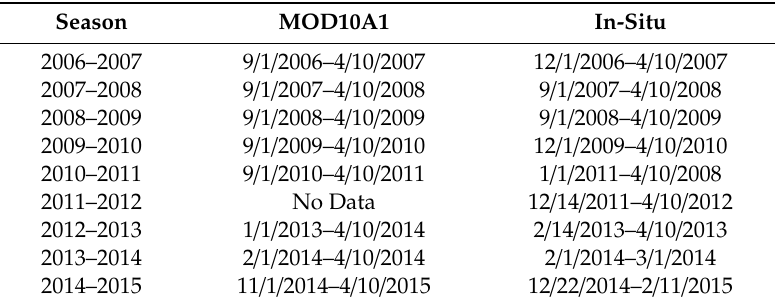
Table 2. Range of dates with MOD10A1 and in-situ albedo at Johnsons